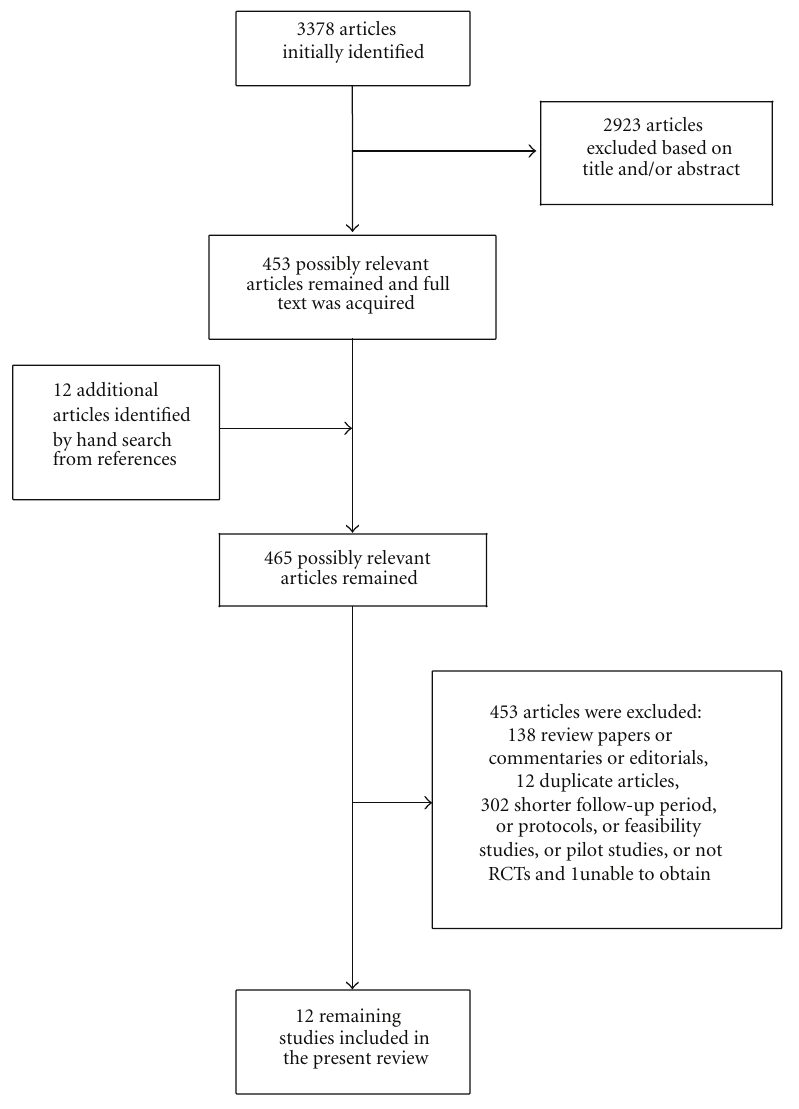
Figure 1: Flowchart of study